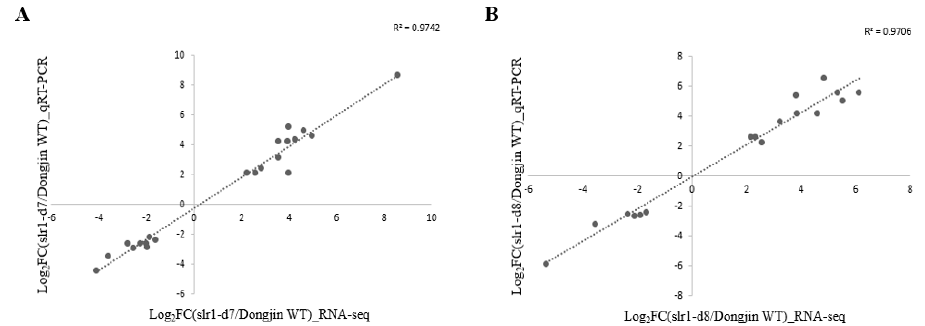
Figure 5. Correlation analysis of gene expression pattern by RNA-Seq and qRT-PCR. ( A ) WT vs. slr1-d7 line, ( B ) WT vs. slr1-d8 line.